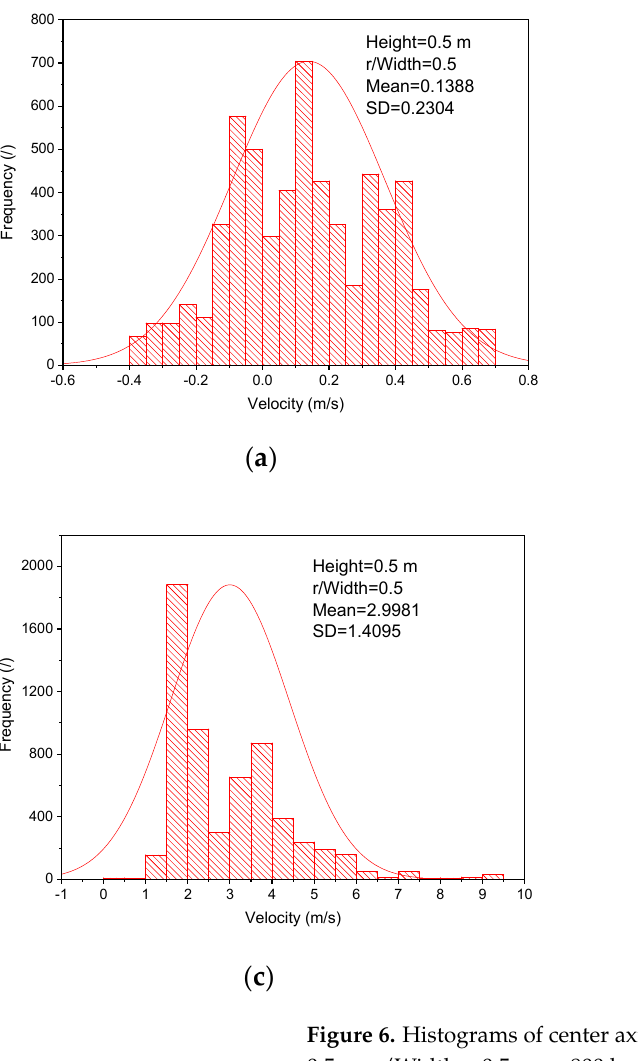
Figure 5. Instantaneous porosities and velocities of particles used in experiment in a bubbling fluidized bed, ρ p = 2700 kg/m 3 .